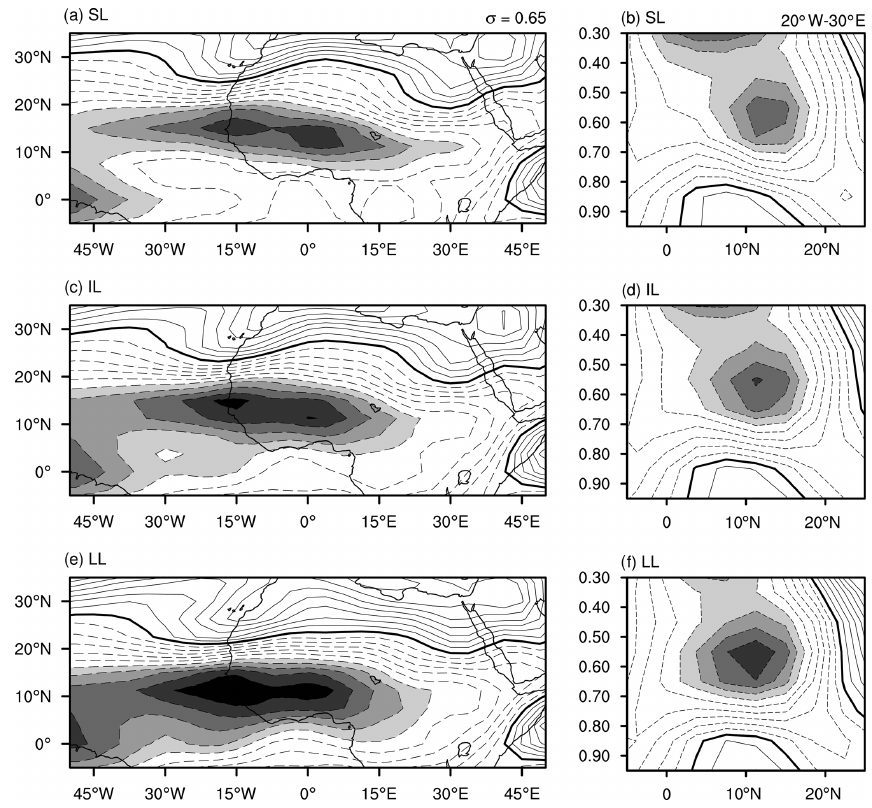
Figure 6. Zonal winds ( < − 6ms − 1 shaded with negative values dashed) at σ = 0 . 65 (a, c, e) and latitude–height cross section averaged over − 15 to 15 ◦ E (b, d, f) for the short-, intermediate-, and long-lived basic states.